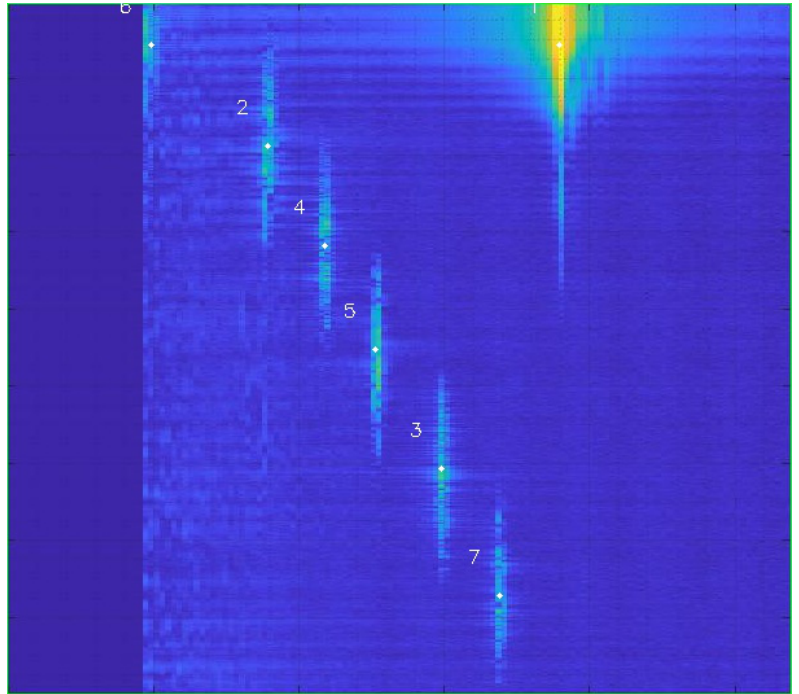
Figure 9. Image showing centroid of each object